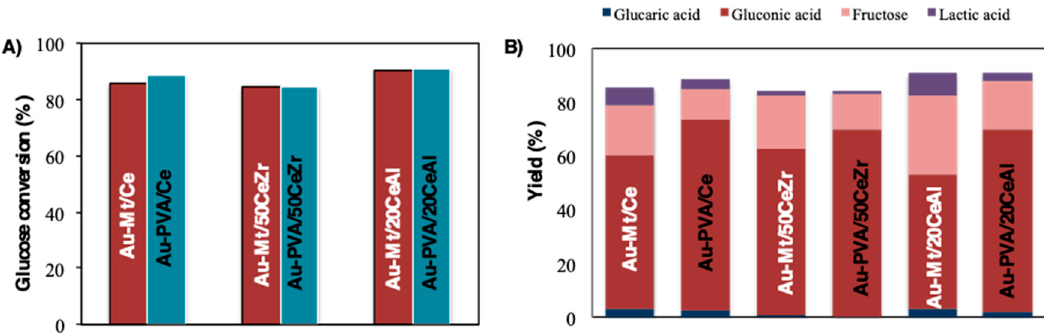
Figure 6. ( A ) Glucose conversion (%) in NaOH presence, glucose: NaOH molar ratio 1:2 (600 rpm, 18 h); ( B ) yield (%).